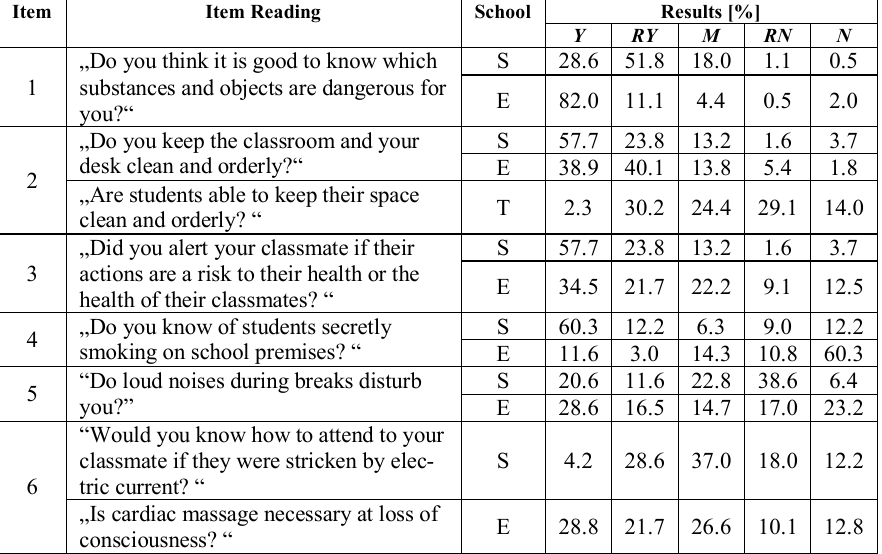
Table 3. Summary Survey